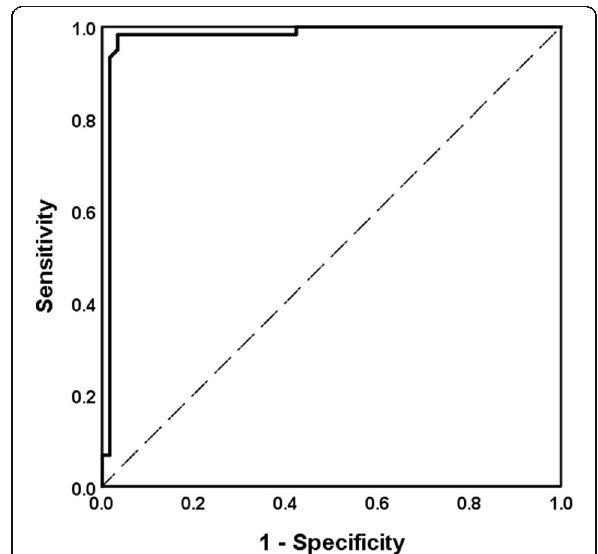
Fig. 1 Sensitivities and specificities of serum markers; ESR, CRP and PCT for SBP diagnosis Fig. 2 Sensitivity and specificity of serum PEC index for SBP